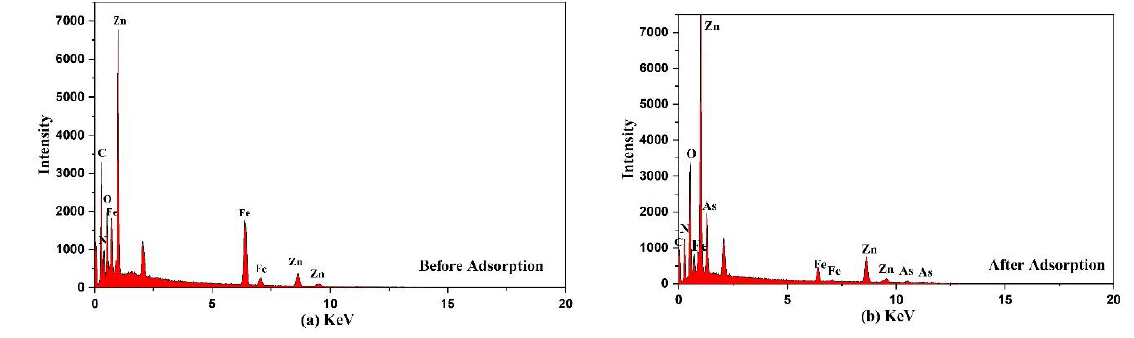
Figure 7. EDS spectra of the adsorbent ( a ) before ( b ) after adsorption. Table 4. EDS analysis of Fe 3 O 4 @ZIF-8 before and after adsorption.